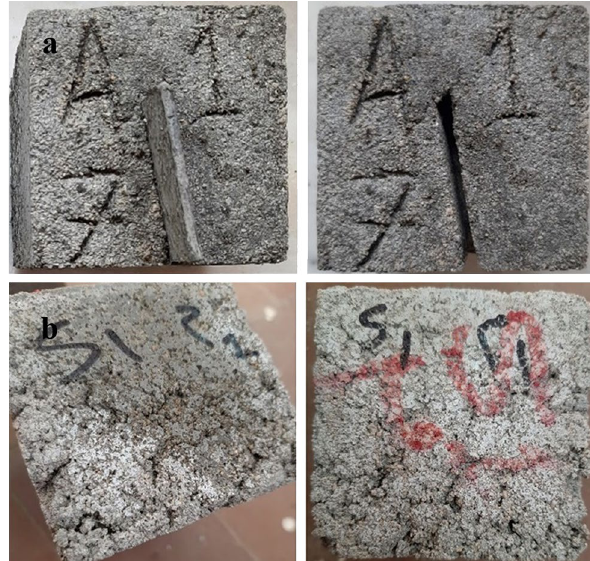
Figure 12. Cracks by a plate of steel ( a ), Natural cracks ( b